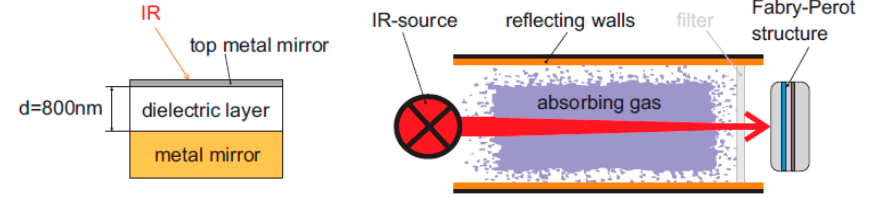
Figure 5. The dielectric layer used for the measurement and the methodology. Ge is used as a dielectric layer. Reproduced with permission from Reference [15]. IR: infrared radiation.